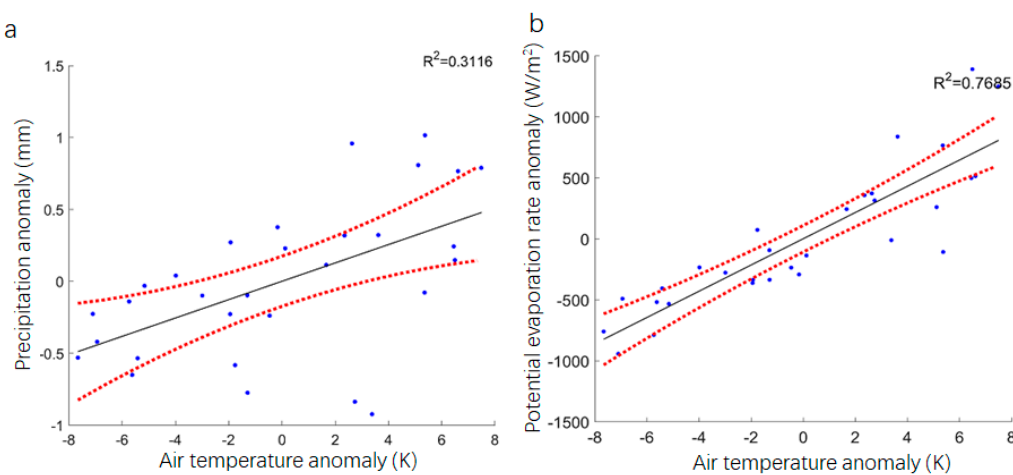
Figure 9. ( a ) Correlation between winter air temperature anomalies and winter precipitation anomalies in the Barents–Kara Sea; ( b ) correlation between winter air temperature anomalies and winter potential evaporation rate in the Barents–Kara Sea. The scatter points in the red dashed area passed the t test at 95% confidence.